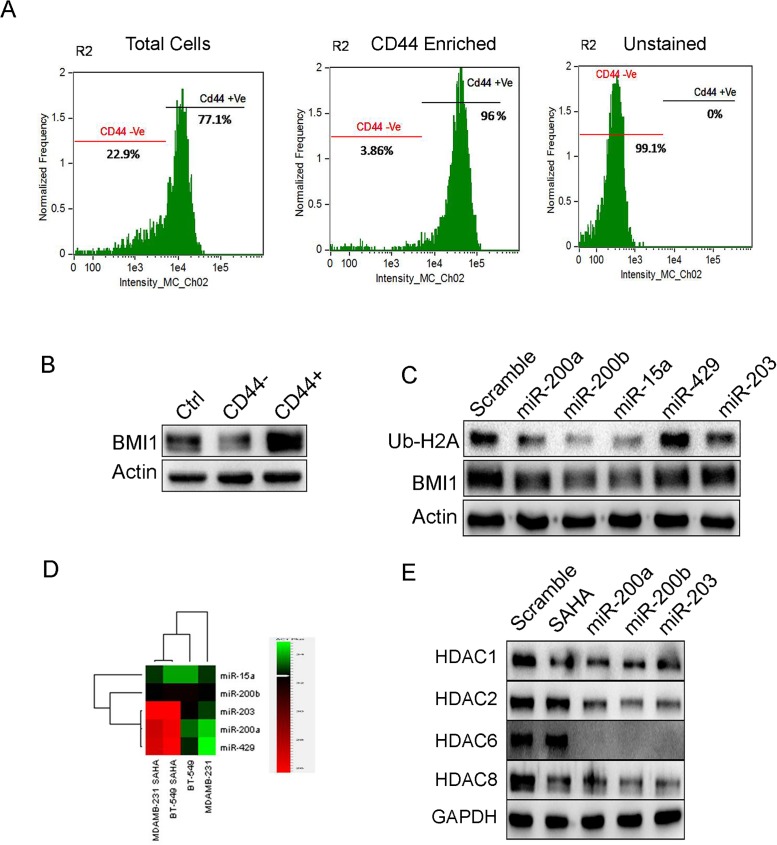
miRNAs reduce expression of BMI1 and Ub-H2A in CD44+ stem cell population of MDAMB-231 cells and down-regulate HDACs expression in MDAMB-231 cells with SAHA treatment.Segregation of CD44+ and CD44- cells by flow cytometry. From the CD44+ enriched population, 96% of the cells were CD44+ and 3.86% of the cells were CD44.Unstained cell population had 99.1% of CD44- cells (A). Expression of BMI1 in CD44+ and CD44- cells (B). Protein expression of BMI1 and Ub-H2A in CD44+ population transfected with miR-200a, miR-200b, miR-15a, miR-429 and miR-203 (C). Actin served as the loading control in (B) and (C). Levels of miR-200a, miR-200b, miR-15a, miR-429 and miR-203 in MDAMB-231 and BT-549 cells treated with SAHA. Untreated cells served as a control (D). Protein expression of various HDACs in cells having overexpression of miR-200a, miR-200b and miR-203. Cells with scramble miRNA were used as control. Cells without miRNA transfection but treated with SAHA served as positive control. GAPDH served as the loading control (E).